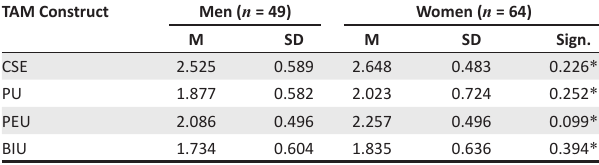
TABLE 3: Ratings of Technology Acceptance Model Constructs by Gender.